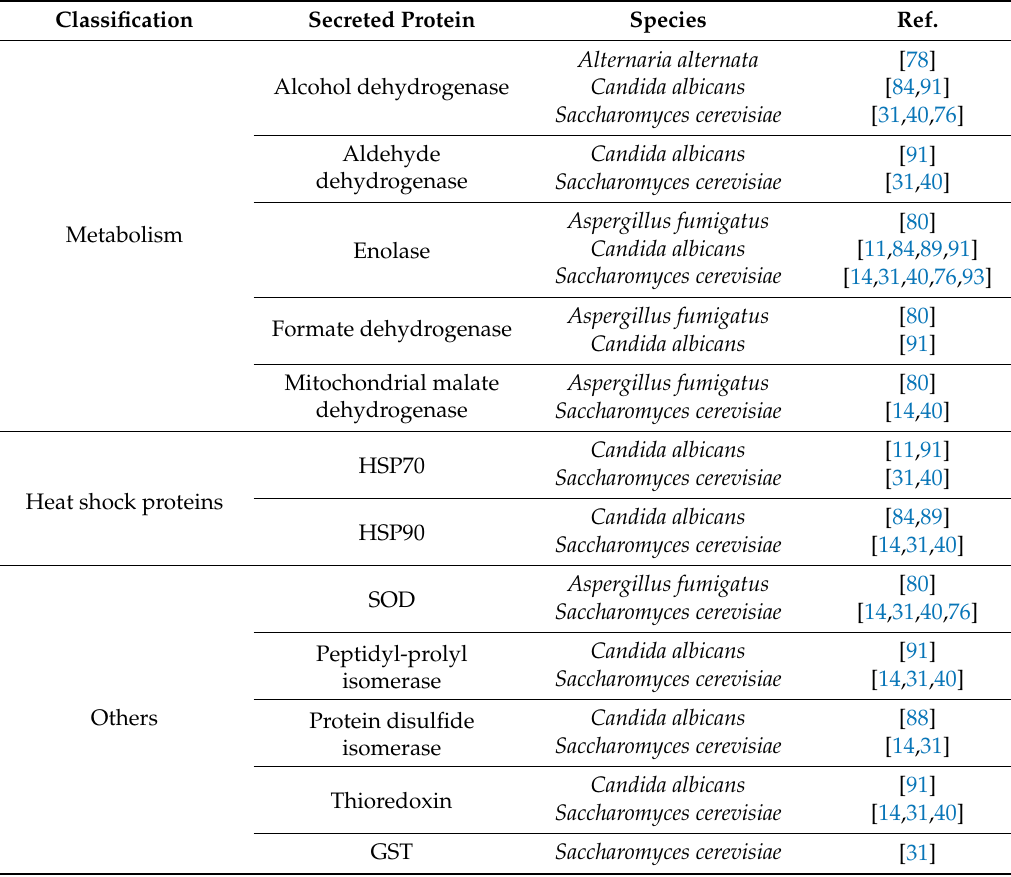
Table 4. Fungal allergen-related proteins detected by secretome